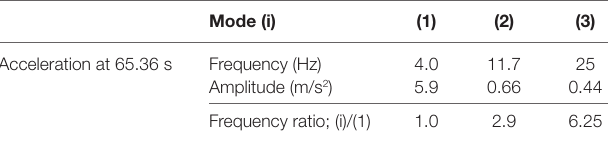
Table 3 | Dominant frequency and amplitude in amplitude spectra